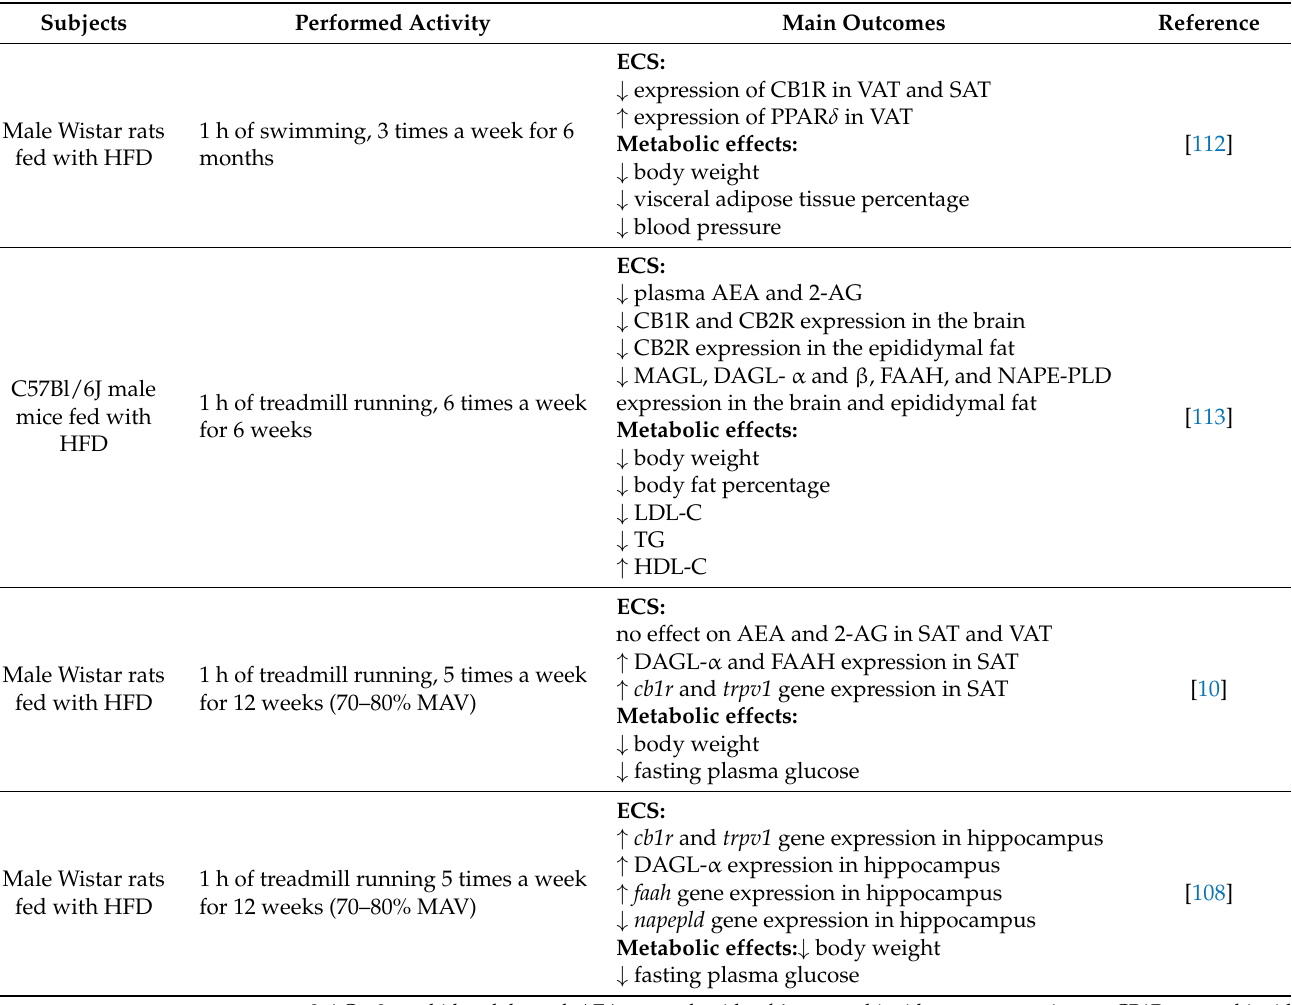
Table 2. A summary of the animal studies showing the correlation between physical activity, alter- ations in the endocannabinoid system, and subsequent beneficial therapeutic effects in metabolic